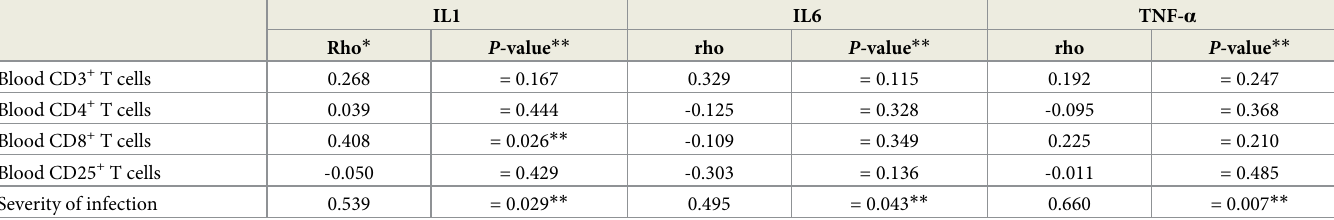
Table 8. Correlation among immune cells, cytokine levels, and the severity of infection among patients.